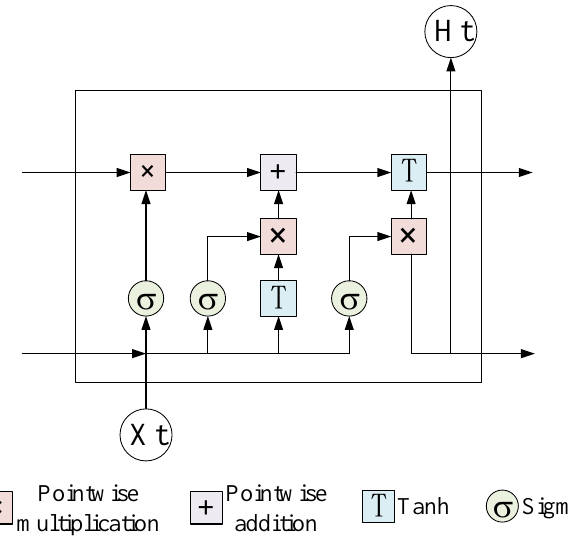
Figure 4. LSTM cell